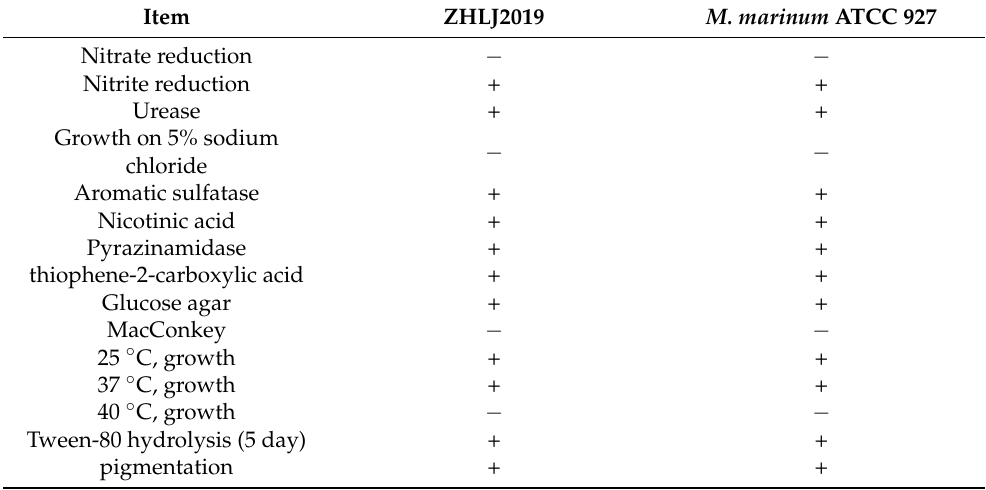
Table 2. Comparison of phenotype characteristics of the strain ZHLJ2019 and M. marinum ATCC 927. Item ZHLJ2019 M. marinum ATCC